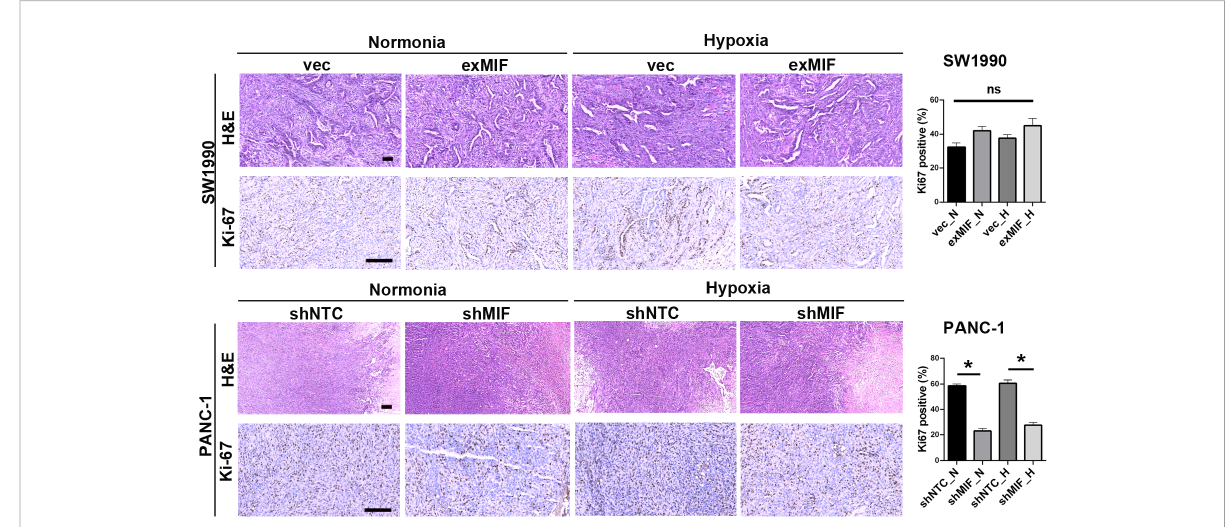
FIGURE 7 MIF knockdown inhibits proliferation of PDAC cells Representative images of xenograft tumours stained for H&E and Ki-67. The histograms show the quanti fi cation of Ki-67 staining; n = 6 per group. * P <